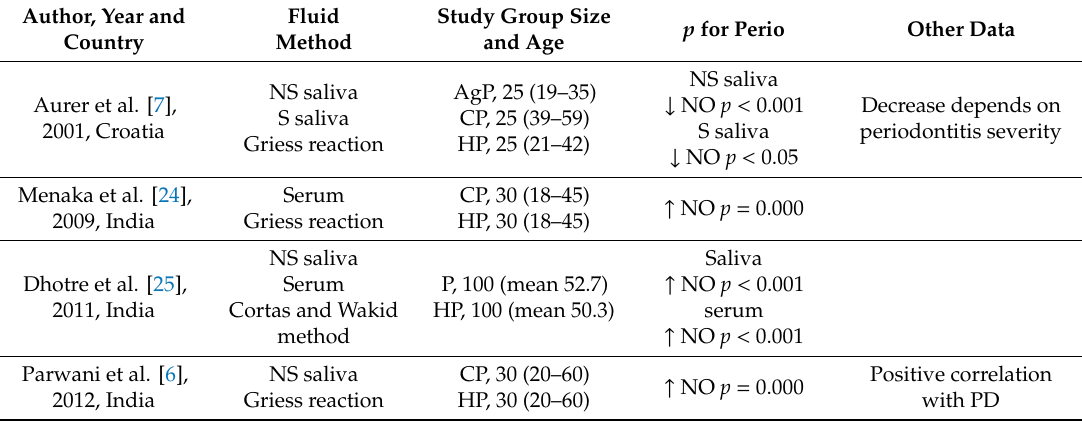
Table 2. Comparison of studies on nitric oxide (NO) concentration in periodontitis.